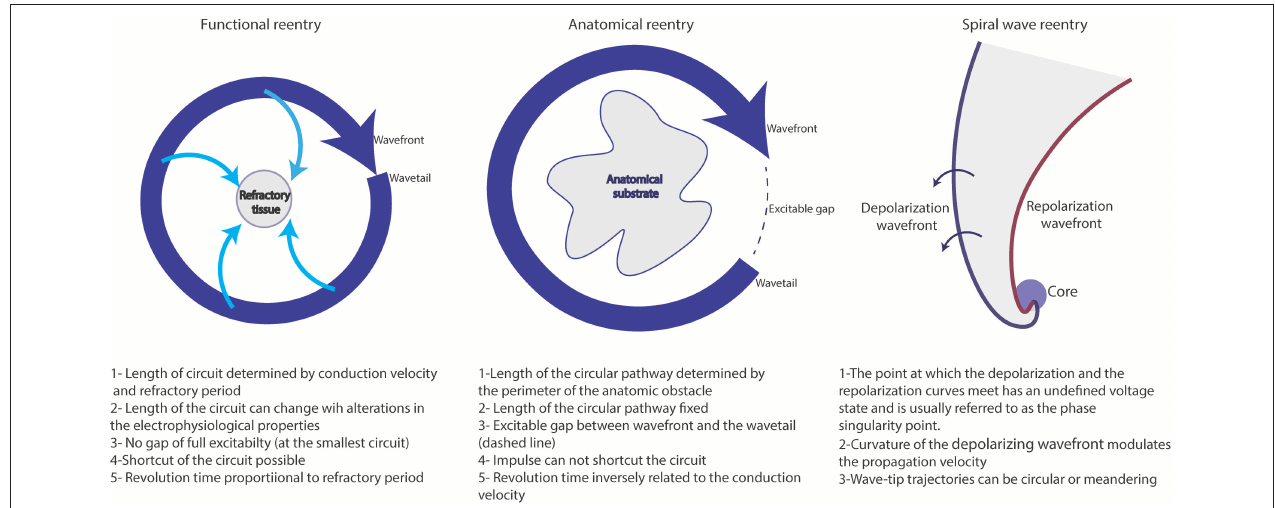
Atrial Remodeling Atrial remodeling includes structural and functional alterations including electric, structural, and autonomic remodeling that promote atrial arrhythmias.